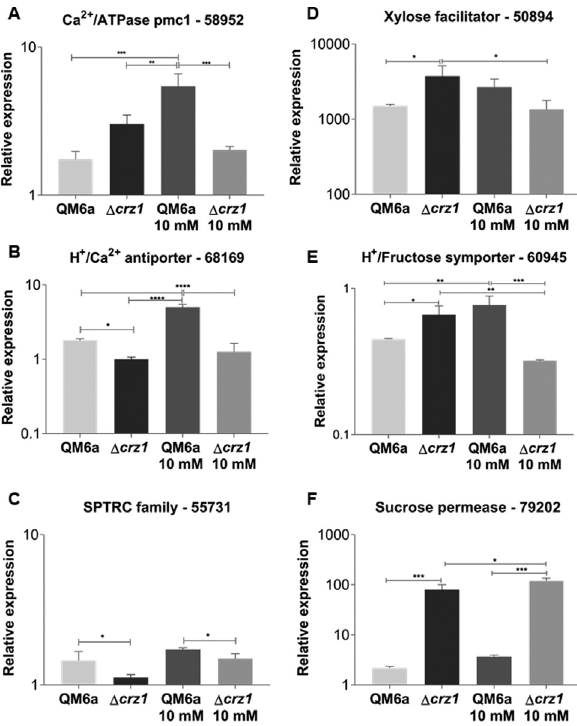
Figure6 -Ca 2+ transportergenes(A-C)andsugartransporter(D-F)differ- ential genic expression in the QM6a and (cid:2) crz1 T. reesei strains after 8 h of growing in SCB and SCB supplemented with 10 mM Ca 2+ . Results are ex- pressed as log 10 means of three biological replicates with standard devia- tion normalized by glycerol expression levels at the same condition. Sta- tistical significance is represented as asterisks, considering p-value as <0.05(*),<0.01(**),<0.001(***)andp<0.0001(****).ProteinIDofthe evaluated genes are supported at T. reesei genome database (https://ge- nome.jgi.doe.gov/pages/search-for-genes.jsf?organism=Trire2 https://ge- nome.jgi.doe.gov/pages/search-for-genes.jsf?organism=Trire2).